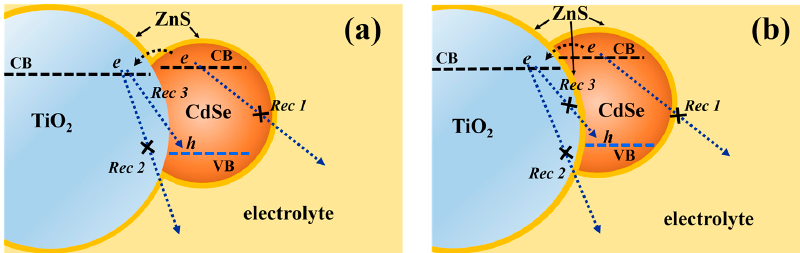
Figure 1. Schematic diagrams of interfacial recombination paths occurring at a photoelectrode. The ZnS coating deposited after the deposition of CdSe quantum dots (QDs) ( a ); and before and after the deposition of CdSe QDs ( b ).